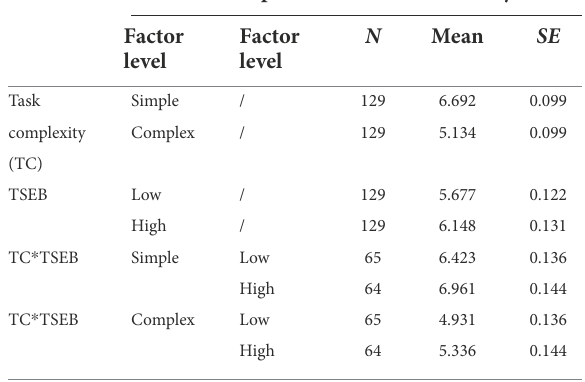
TABLE 3 Self-reported cognitive effort—significant effect of task complexity.